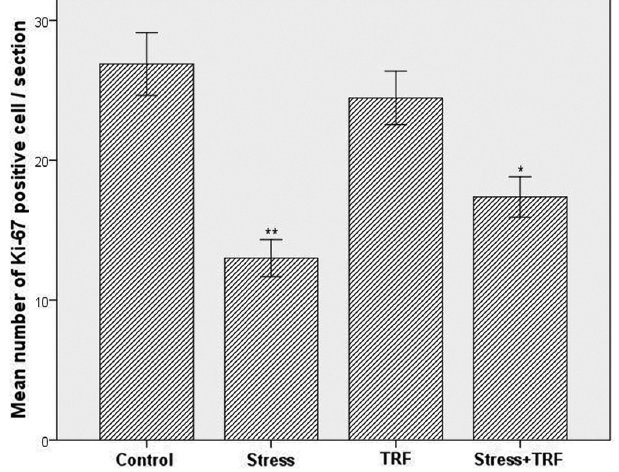
FIGURE 3 – The number of actively dividing cells in the subgranular layer of the dentate gyrus, labelled by the Ki-67 antibody (blue arrows) in the control group (A), stressed group (B), tocotrienol-treated group (C) and the stressed group treated with tocotrienol (D). G – granular cell layer; H – hilus of the dentate gyrus; M – molecular layer. Scale bar represents 100 µm.